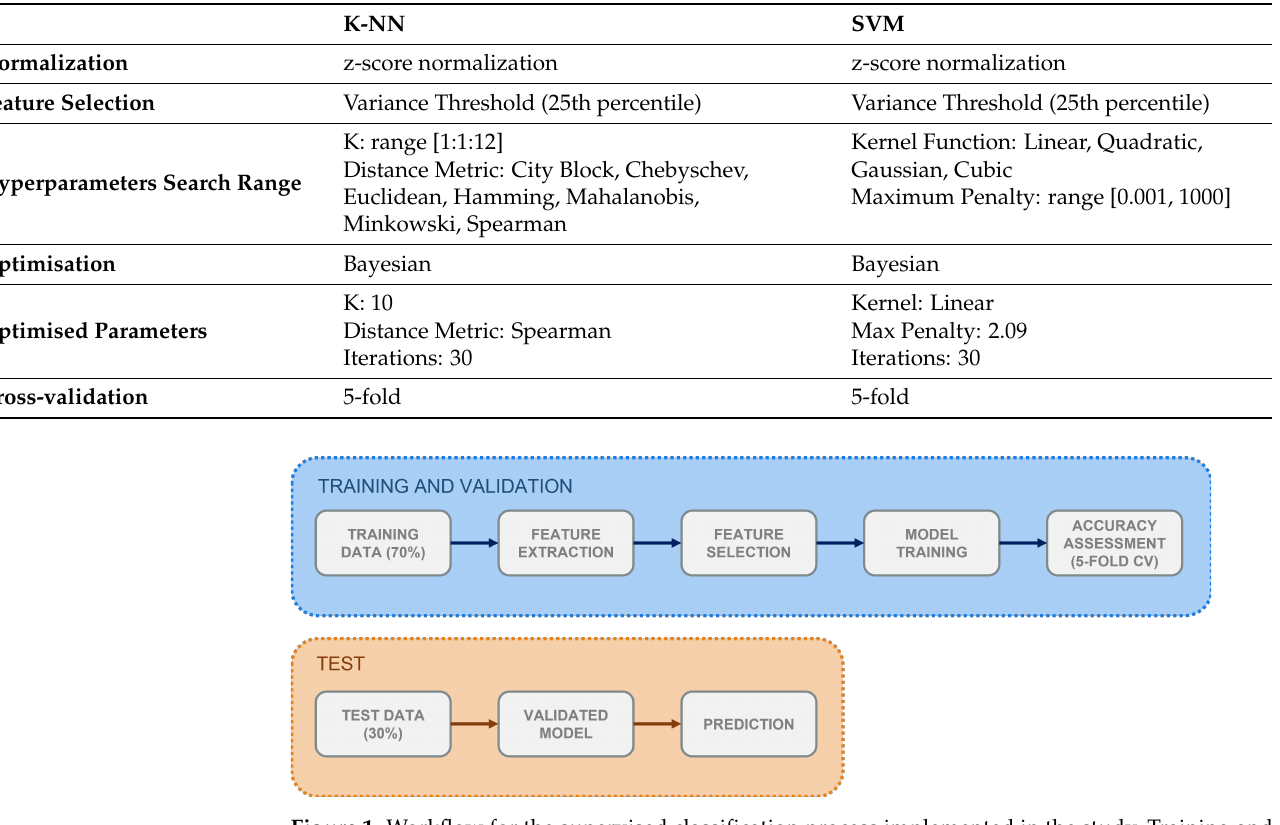
Figure 1. Workflow for the supervised classification process implemented in the study. Training and validation, test-set